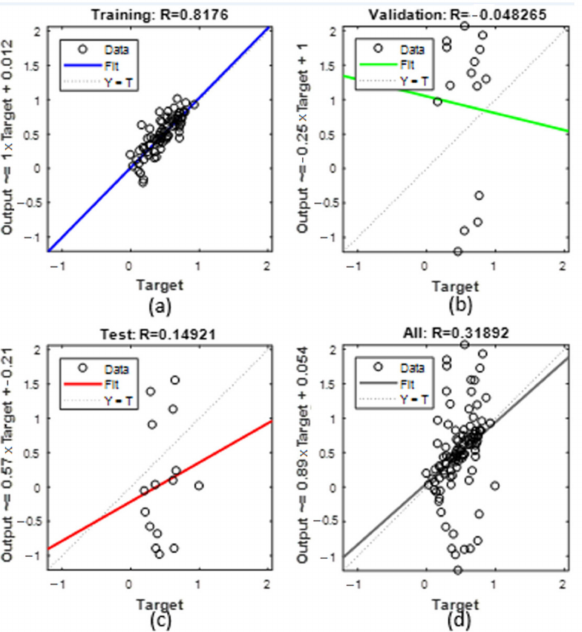
Figure 6. Regression and correlation coefficient using 500 neurons in the hidden layer for stage ( a ) the training phase, ( b ) validation, ( c ) testing, and ( d ) overall.